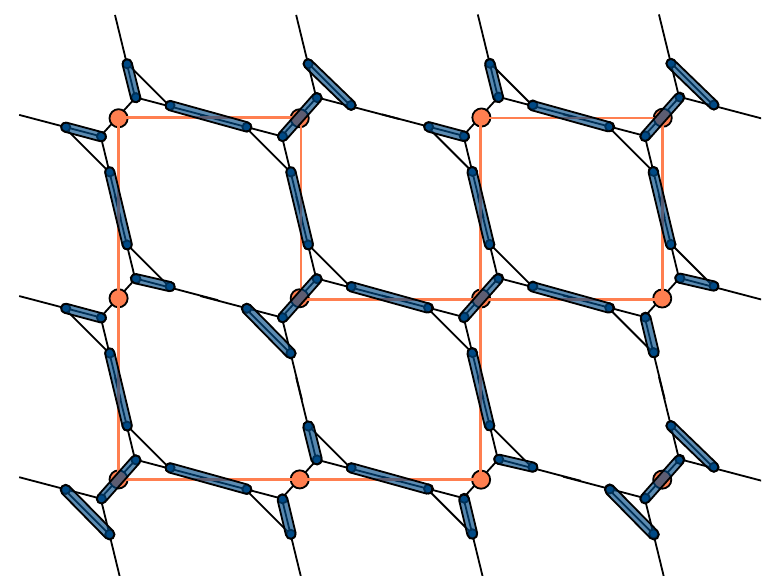
Figure 2: Example for the dimer representation of the graphical interpretation of the partition function on a ( L = 4 ) × ( M = 3 ) lattice. The original lattice sites are depicted as large circles, while the orange lines are one example for a polygon